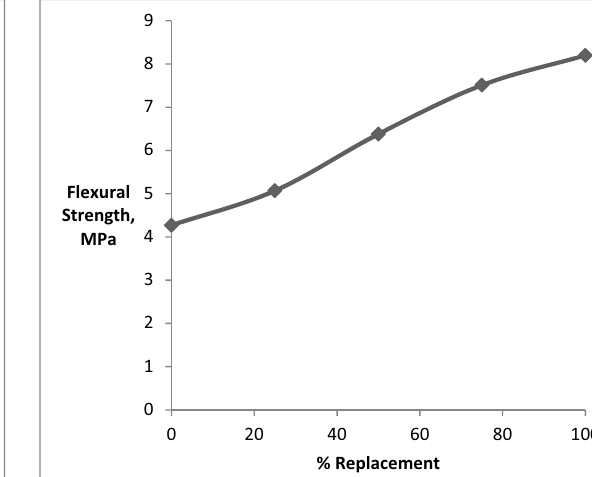
Figure 7: Relation between % replacement and compressive strength of concrete modi fi ed with PC superplasticizer.